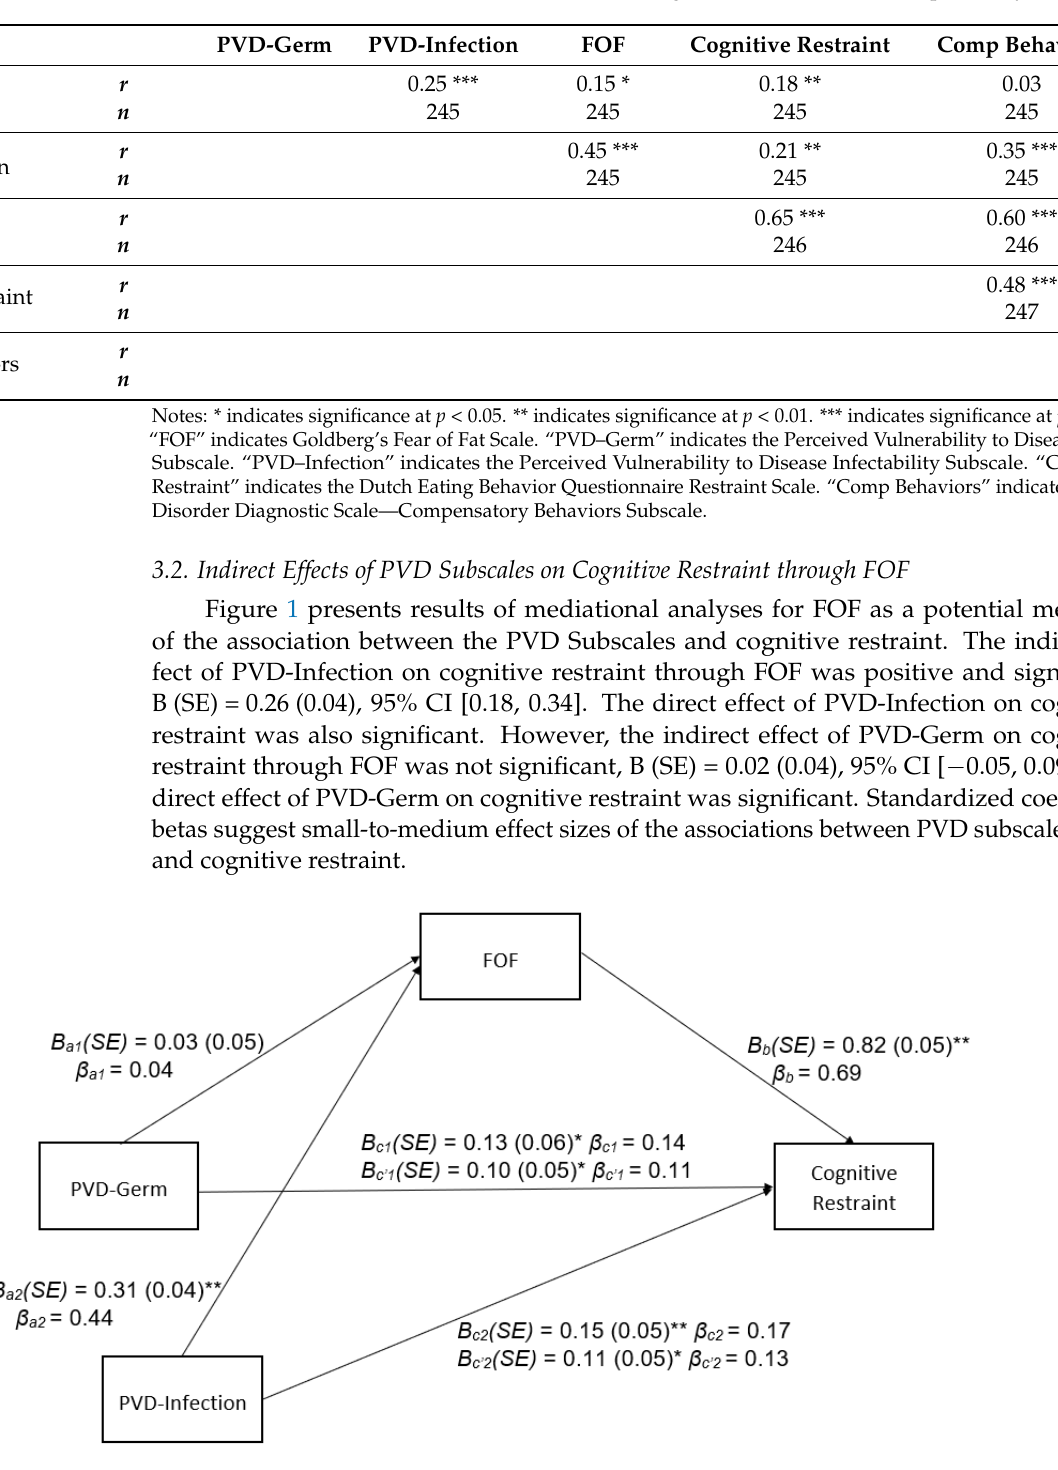
Figure 1. PVD Subscales and Cognitive Restraint Mediated by FOF. Process Model—4 path estimates from testing the indirect effect of perceived germ aversion (PVD-Germ) and perceived in- fectability (PVD-Infection) on cognitive restraint through fear of fat (FOF). Standardized coefficients ( β ), unstandardized coefficients ( B) , and standard errors ( SE) are presented (* p < 0.05, ** p < 0.01).